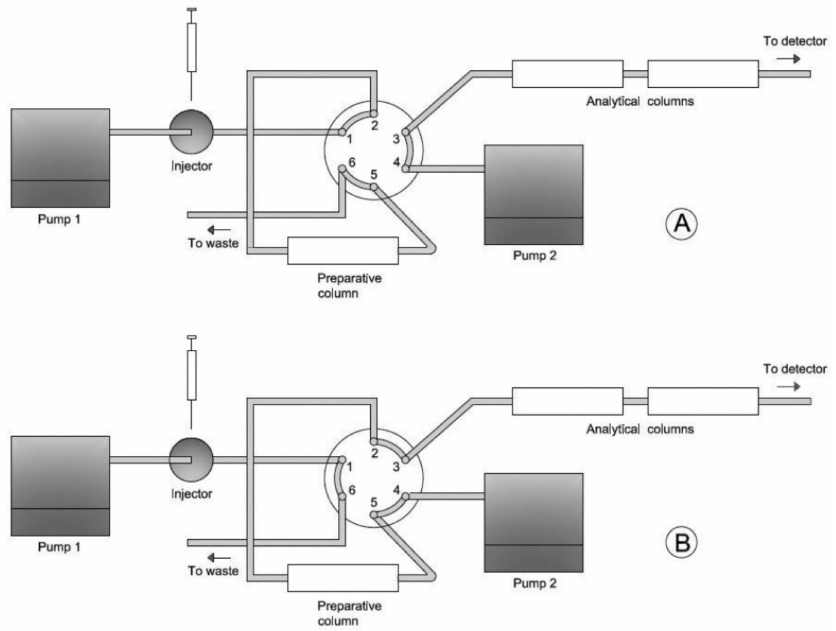
Figure 1. HPLC system used for PAH sampling and determination with loading ( A ) and injecting ( B ) positions of 6-port valve. Reprinted with permission from [74]. Copyright 2015 Copyright HR